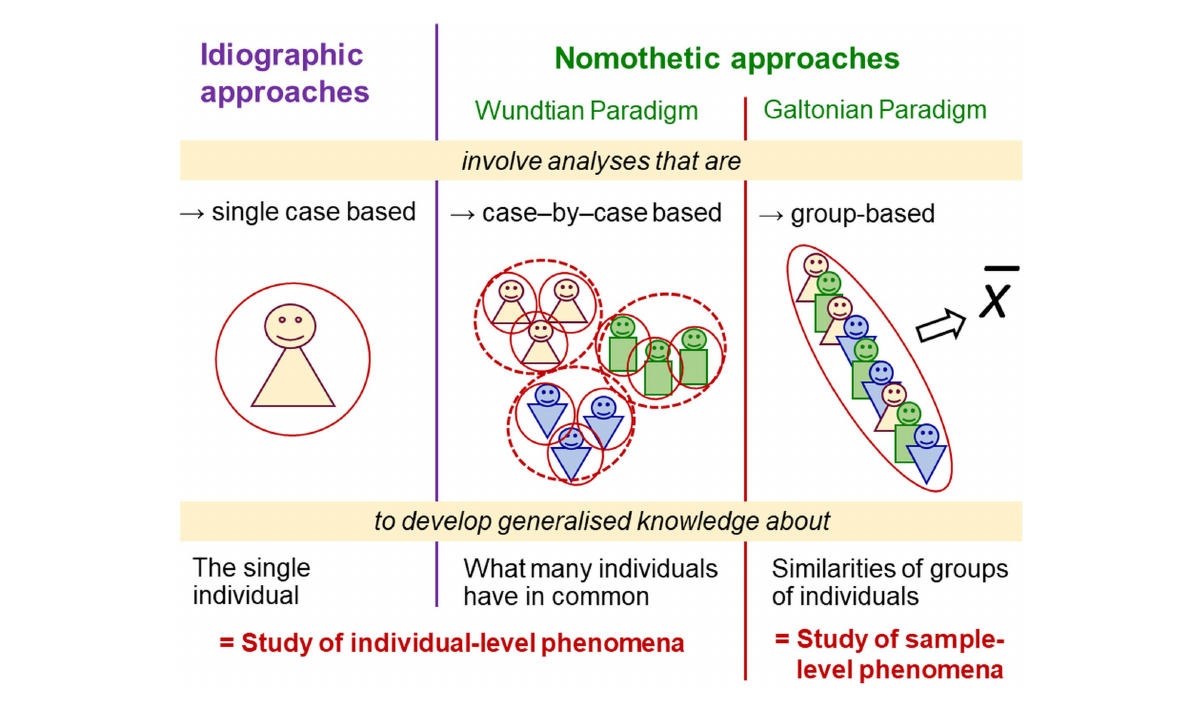
FIGURE 11 Strategies of knowledge generation. Idiographic approaches involve single case based analyses. In case–by–case based nomothetic approaches (Wundtian Paradigm), individuals are grouped by the commonalities and differences that they exhibit in the study phenomena, which enables the development of generalised knowledge and theories about intra-individual processes and functioning. In group-based nomothetic approaches (Galtonian Paradigm), by contrast, individuals are grouped by properties that the researchers find a-priori relevant, which inevitably influences and limits the concepts and theories that psychologists can develop about the phenomena studied (methodomorphism) and precludes identifying what individuals have indeed in